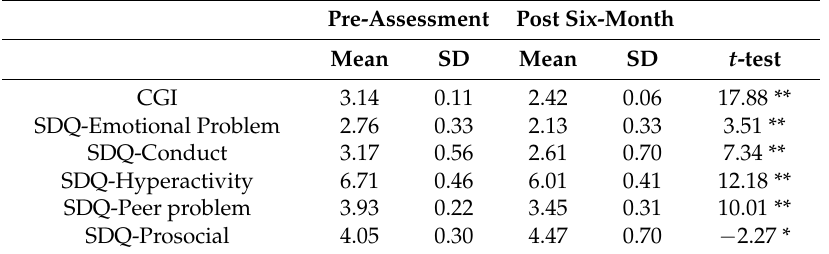
Table 2. Means and standard deviations of clinical outcomes at pre and post (six-month)